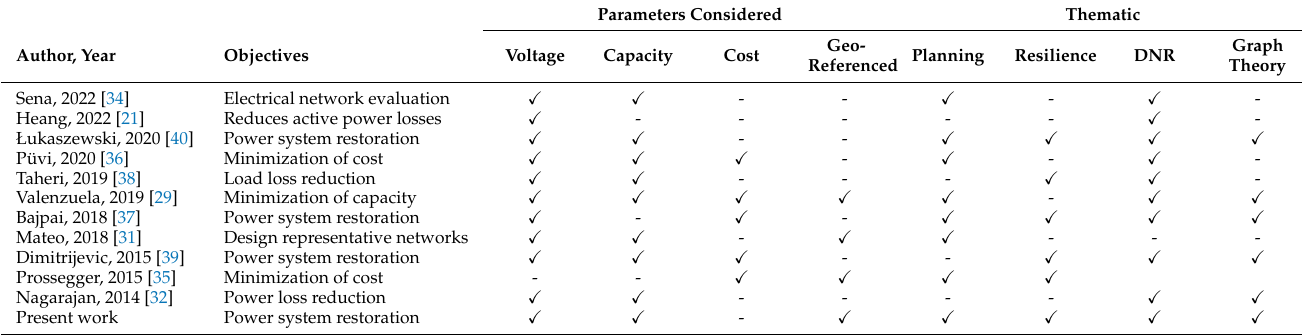
Table 1. Summary of related